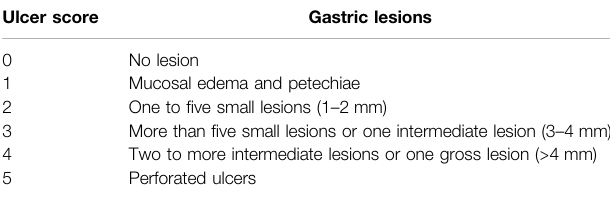
TABLE 1 | Gastric ulcer scoring system based on the severity of ulcer. Ulcer score Gastric